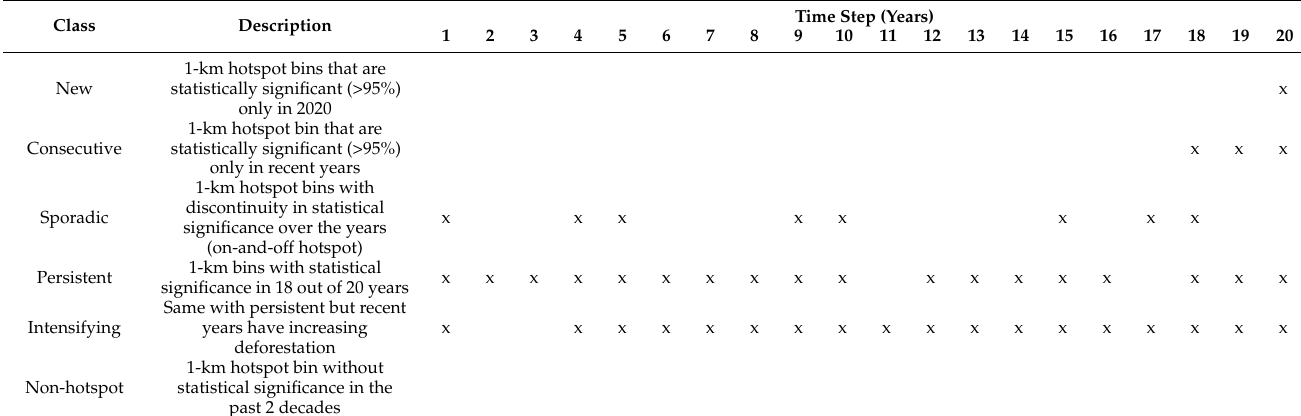
Table 2. Hotspot classes and their description. The time step represents 2001–2020 years (2001–2019 = GFC loss data; 2020 = alert products). The x rows depict “statistical significance of deforestation” per year or simply those classified by EHA as a